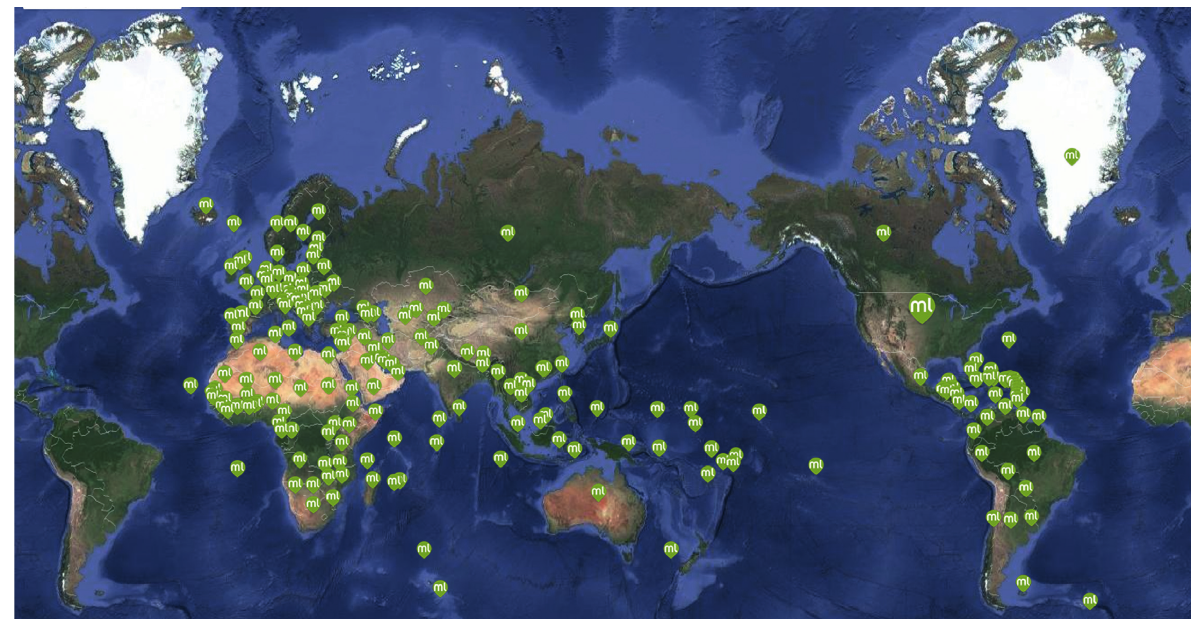
Figure 1: Global user distribution map of